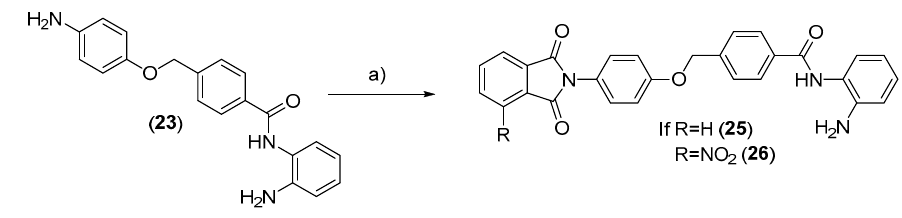
Figure 9. Synthesis of compounds ( 20 )–( 24 ).